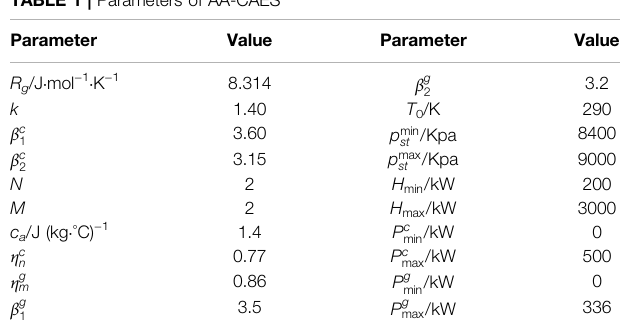
TABLE 1 | Parameters of AA-CAES